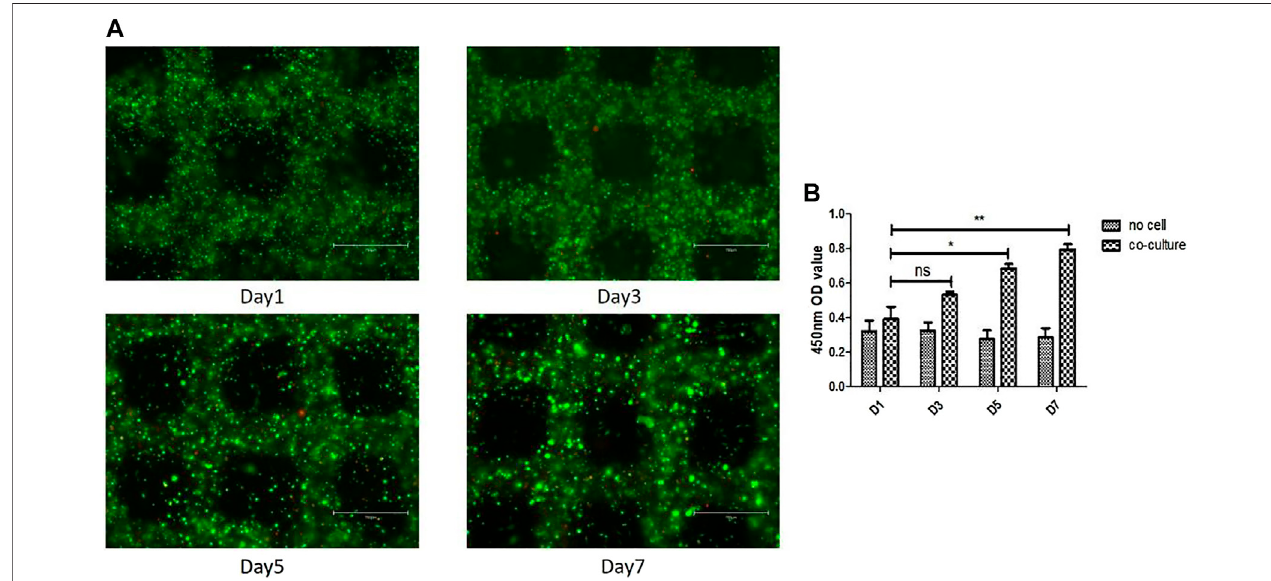
FIGURE 3 | Cell survival and proliferation in the 3D cell laden pannus tissue model. (A) Cell survival at different time points after printing. Live and dead cells were labelled with calcein-AM (green) and PI (red), respectively. Scale bar, 750 μ m. (B) Proliferation rates of cells in 3D co-culture cell laden scaffolds at day 1, 3, 5, and 7.